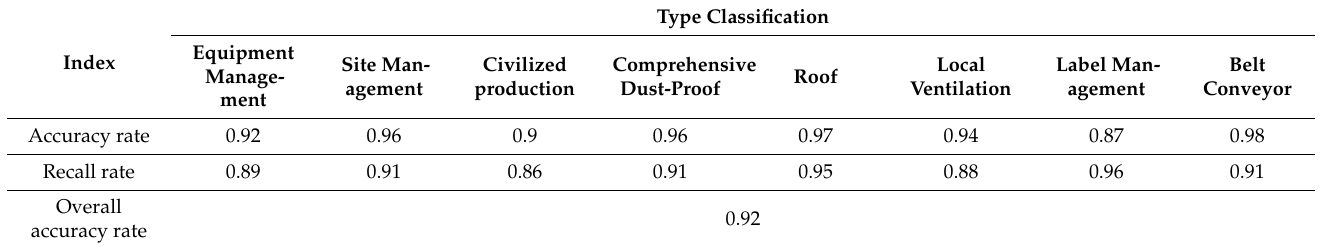
Table A2. Classification experiment